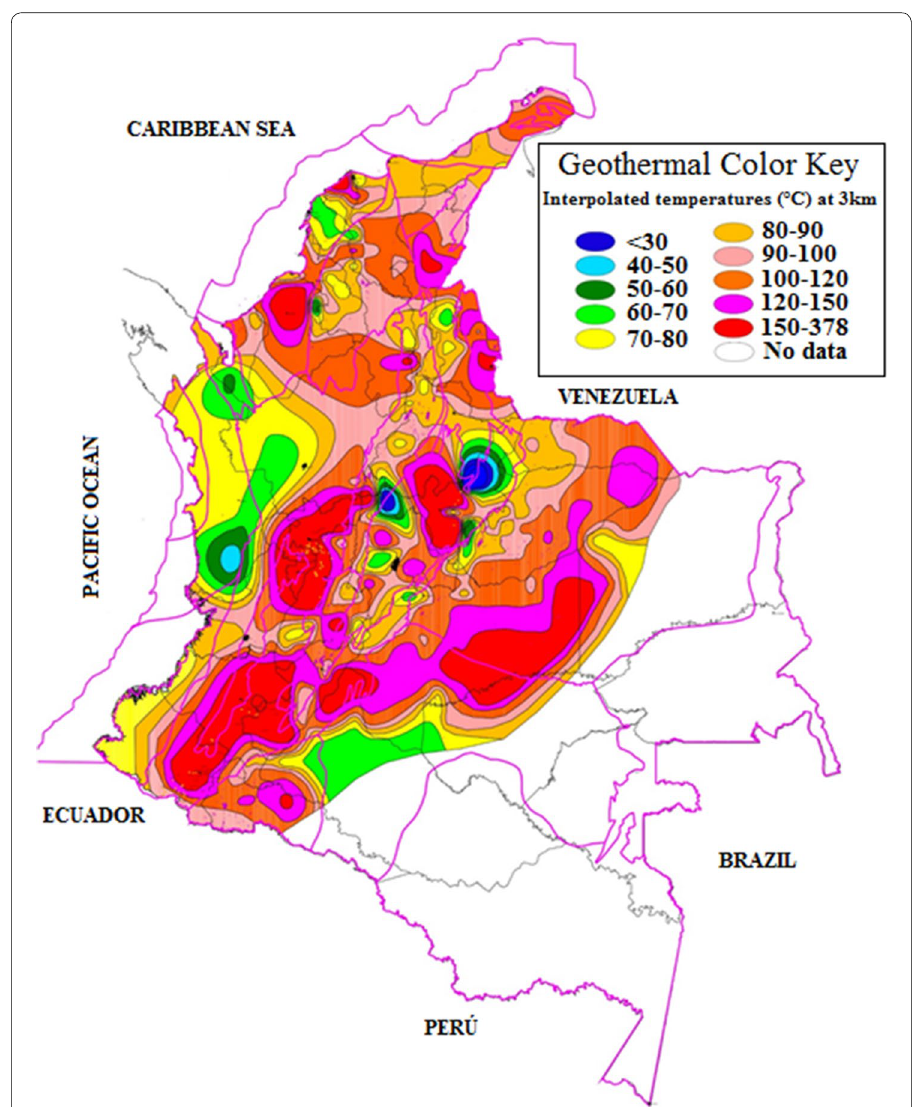
Fig. 3 Geothermal potential map [temperature in °C (at depth of 3 km)] (Reproduced with permission from Vargas et al.